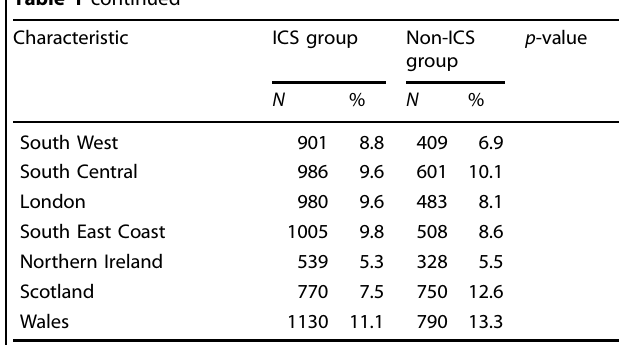
Table 1. Baseline characteristics of patients in the ICS and